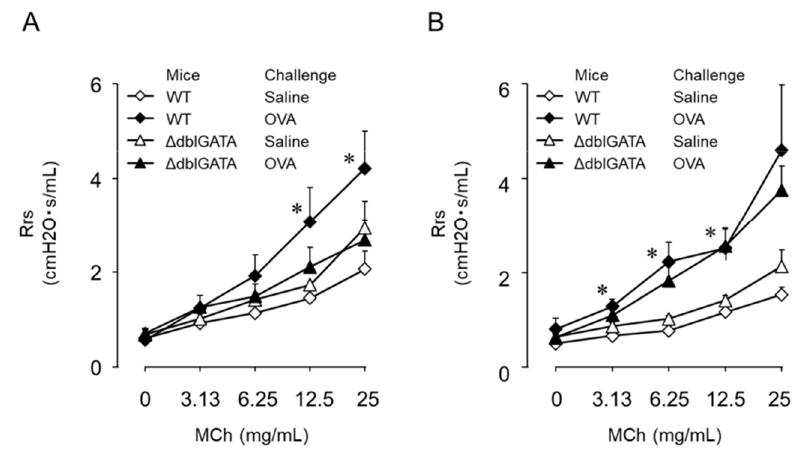
Figure 2. Antigen-induced airway inflammation in Th2 and Th9 cell-transferred mice. Th2 ( A ) or Th9 ( B ) cell-transferred wild-type (WT) and eosinophil-deficient Δ dblGATA mice were challenged with ovalbumin (OVA) or saline. Seventy-two hours after the challenge, bronchial responsiveness to inhaled methacholine (MCh) was assessed. Data are expressed as mean ± SEM of 3–10 animals. * p < 0.05 compared with saline-challenged WT mice. (Reference [38], modified).